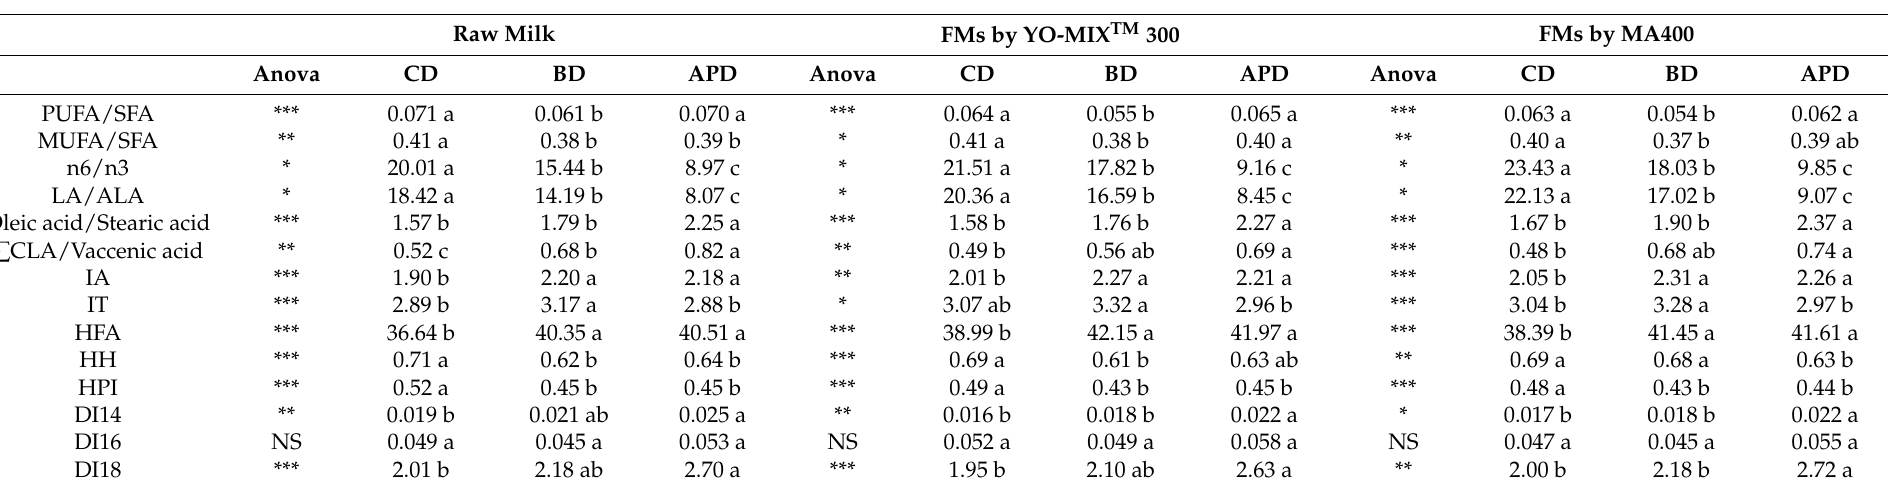
Table 9. Fatty Acids ratios and healthy indexes in raw milk and fermented milks manufactured by late lactation milk and stored for 30 days with milk from Murciana-Granadinas goats fed with differentiated diets, using a thermophilic (YO-MIX TM 300) and mesophilic (MA400) starter cultures. Raw Milk FMs by YO-MIX TM